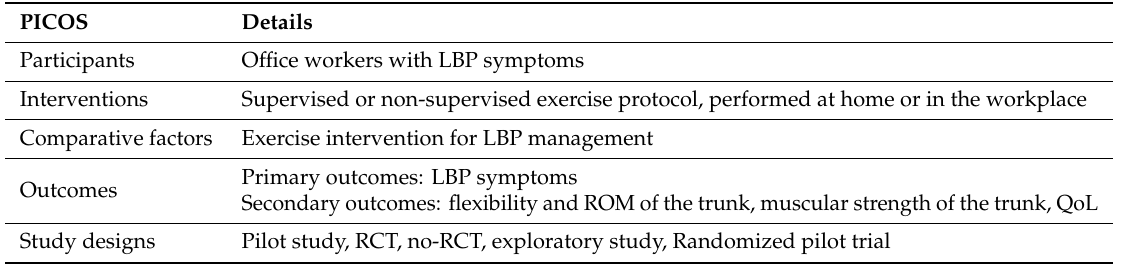
Table 1. Participants, interventions, comparators, outcomes, study (PICOS)